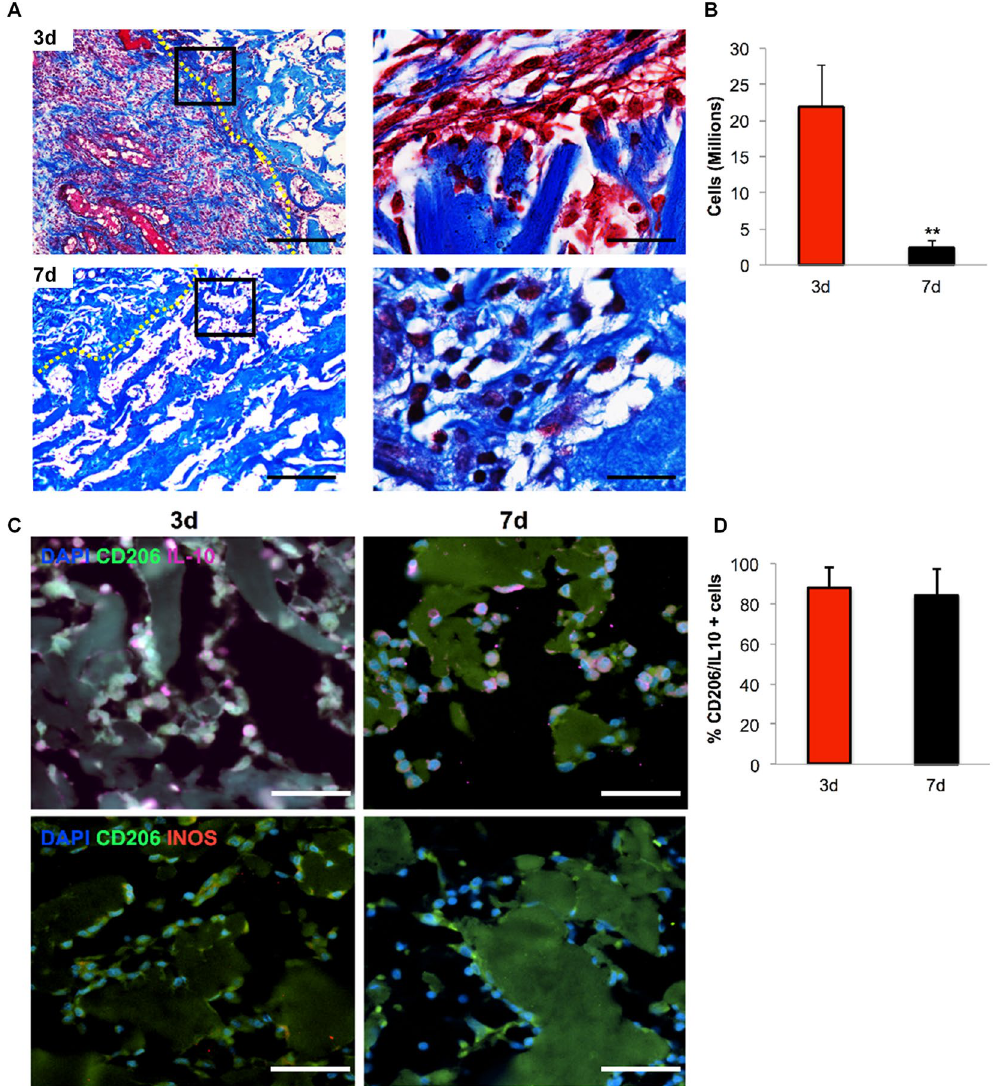
Figure 4. Switching off of inflammation. ( A ) Representative images of Masson’s stained sections of CSCL (dotted yellow lines mark the interface with the native tissue) at 3 (top) and 7 days (bottom) (Scale bars: 100 μ m, 50 μ m). Images highlight dampen of the inflammation representing in a decrease of infiltrating cells from the surrounding tissue and an augment of extracellular matrix deposition. ( B ) Reduction in the number of cells harvested from explanted CSCL at 3 and 7 days. Values are mean ± SD (n = 3) (n = 3, ** p < 0.01). ( C ) Representative immunofluorescence consecutive sections showing anti (IL-10)- and pro(iNOS)- inflammatory markers. Cells are counterstained with anti-Macrophages antibody. A progressive reduction of IL-10 + and iNos + macrophages between 3 and 7 days is shown (scale bars 50 μ m). ( D ) Flow cytometric analysis shows the percentage of IL10 + /CD206 + macrophages at 3 and 7 days from CSCL